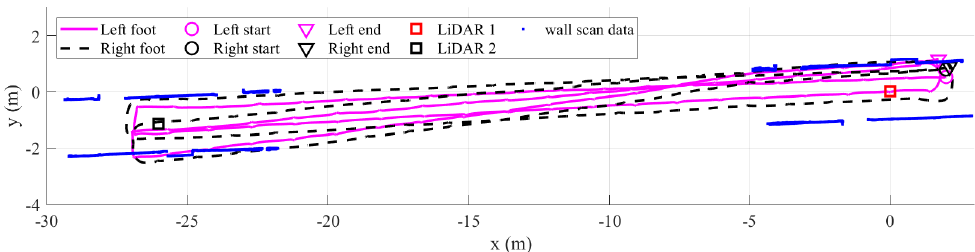
Figure 16. The estimated trajectory inthe rectangular path walking experiment, in which the LiDAR data are not